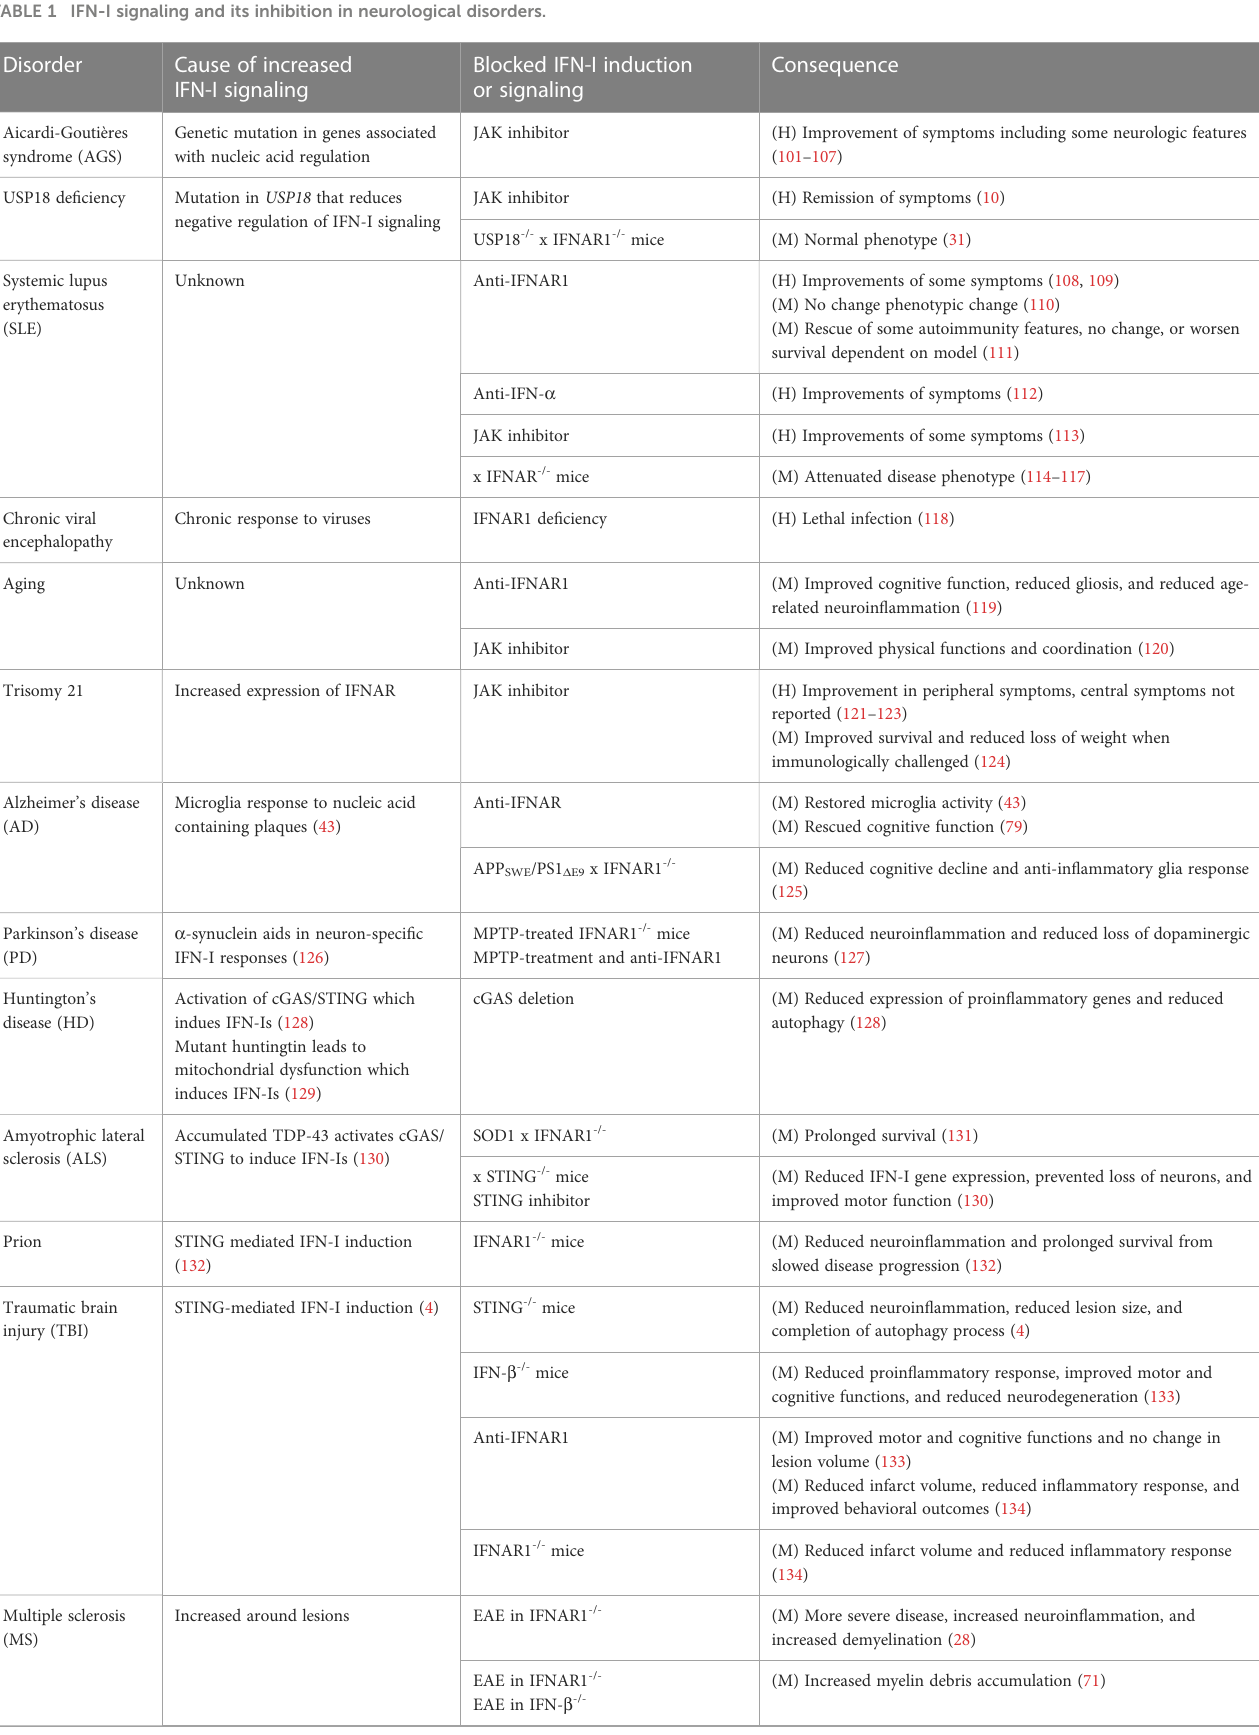
TABLE 1 IFN-I signaling and its inhibition in neurological